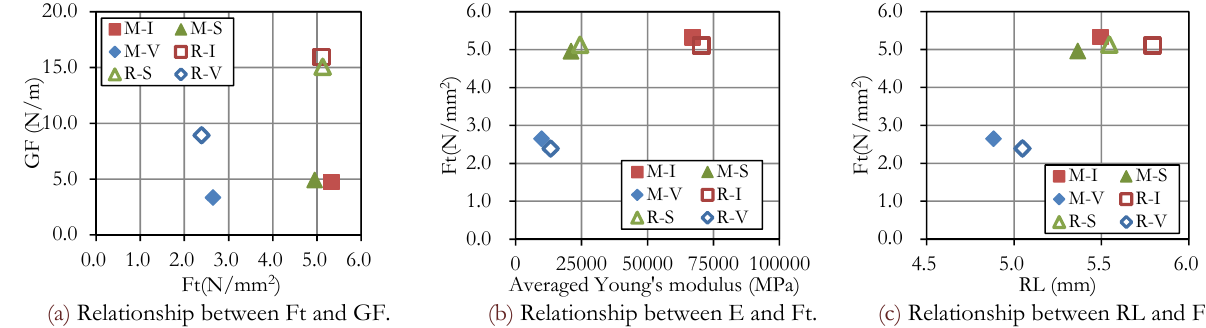
Figure 11: Relationship between mechanical properties or between features of repair and Ft.